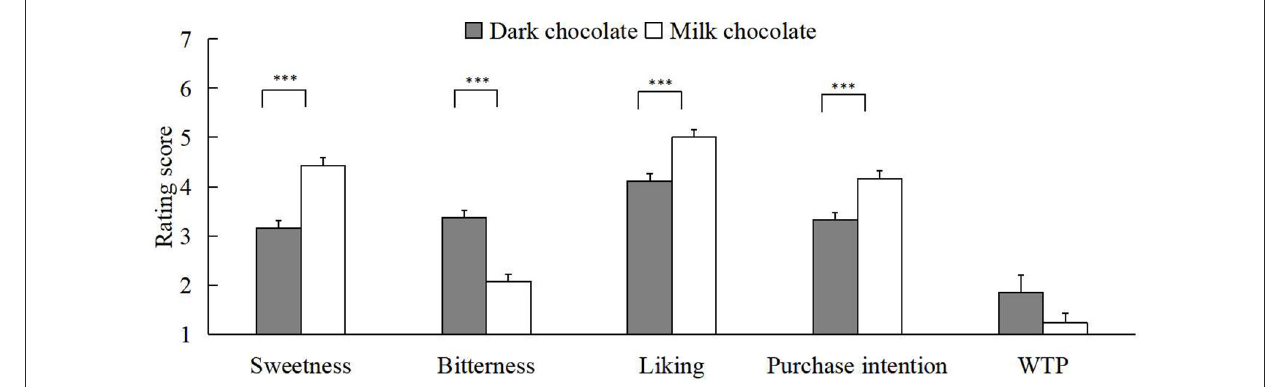
FIGURE2 The main effect of chocolate is on the five dimensions. Note that error bars show the standard errors of the means, *** p < 0.001.